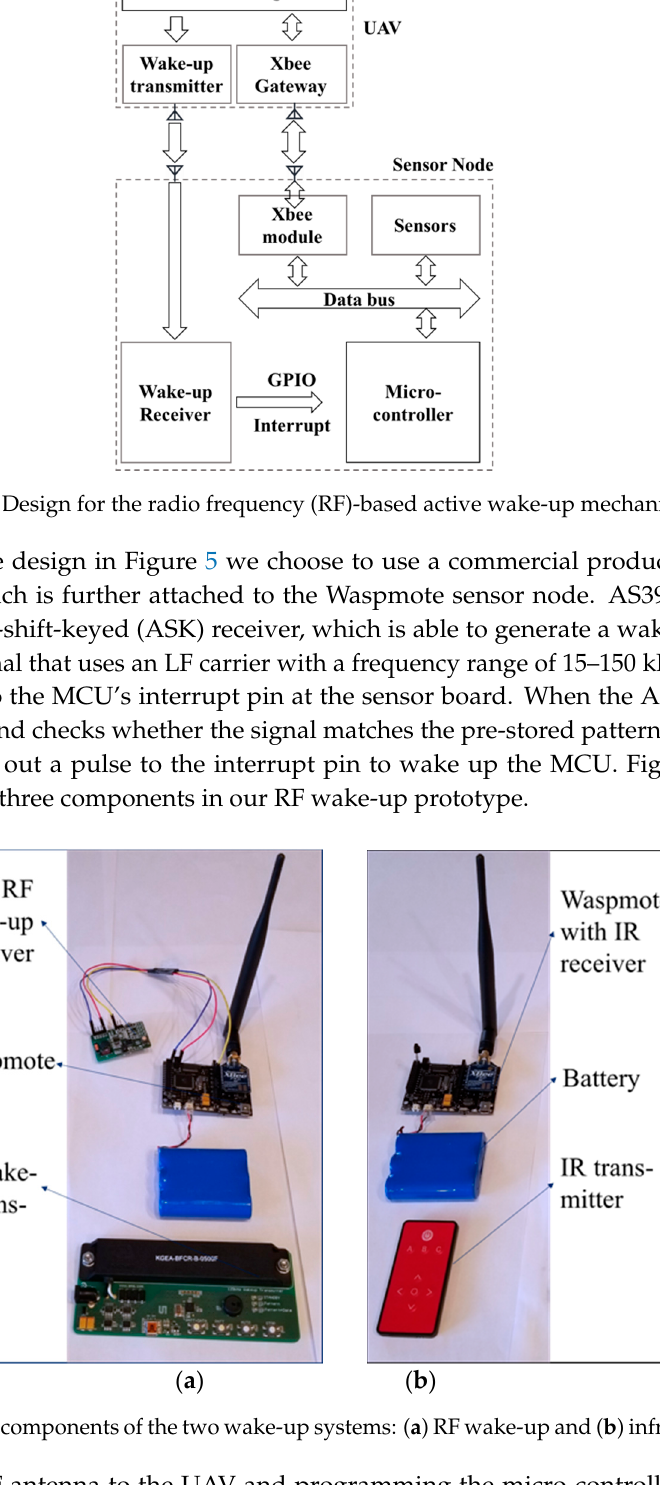
Figure 6. Hardware components of the two wake-up systems: ( a ) RF wake-up and ( b ) infrared wake-up.